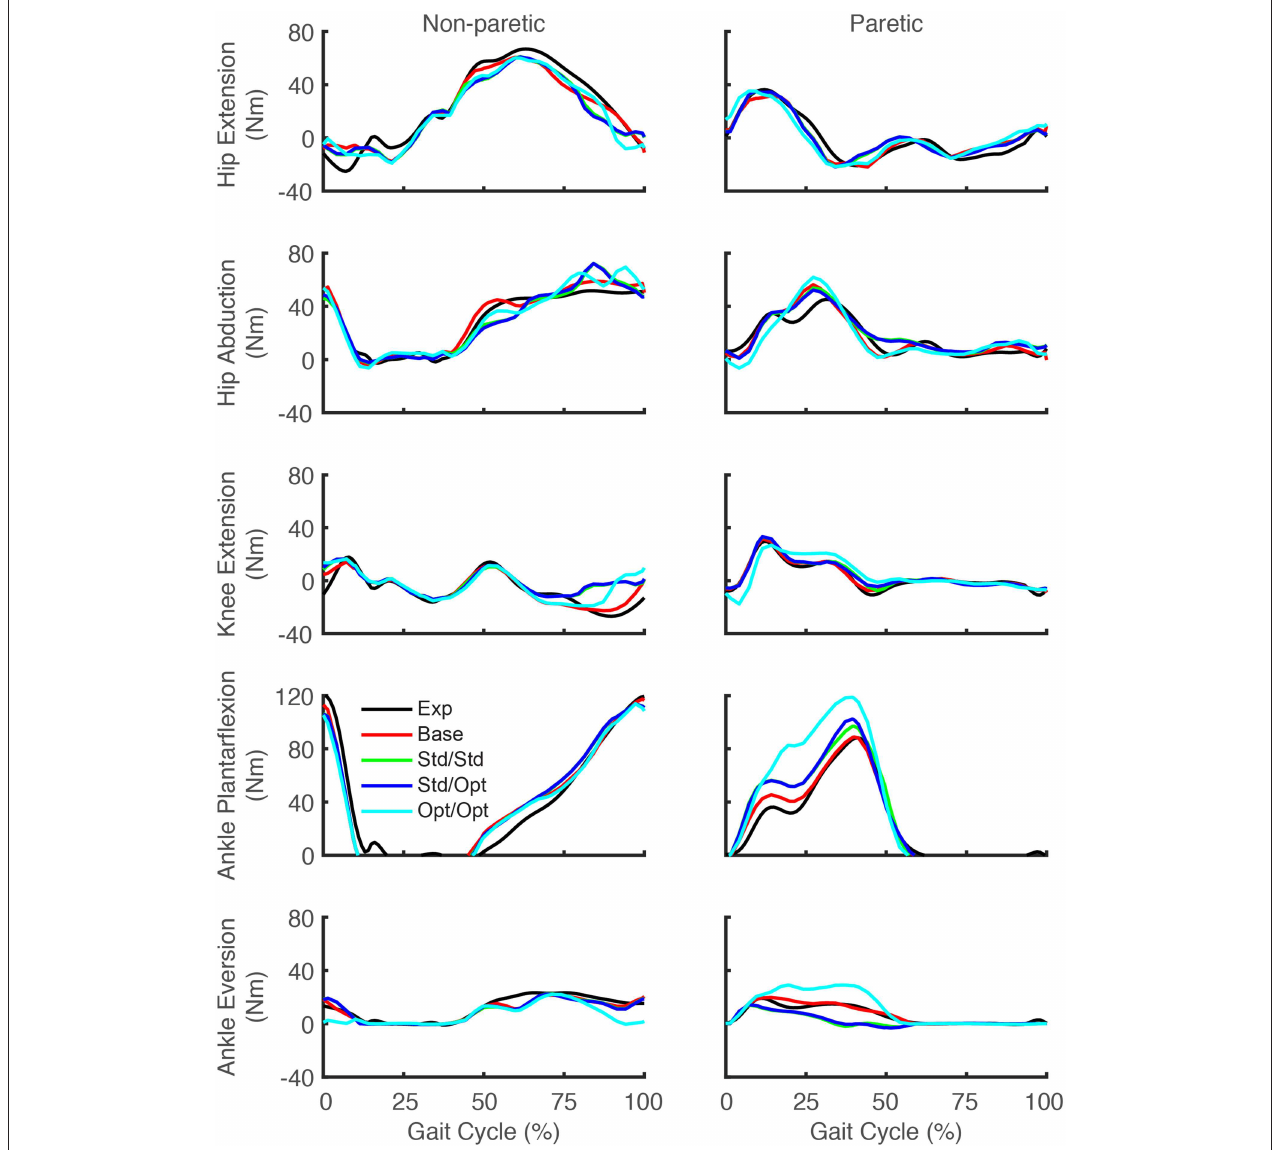
FIGURE 6 | Experimental and predicted lower body joint moments over the gait cycle. Hip extension moment (first row), hip abduction moment (second row), knee extension moment (third row), ankle plantarflexion moment (fourth row), and ankle eversion moment (fifth row) are presented for the non-paretic leg (left column) and the paretic leg (right column). The legend is the same as in Figure 2